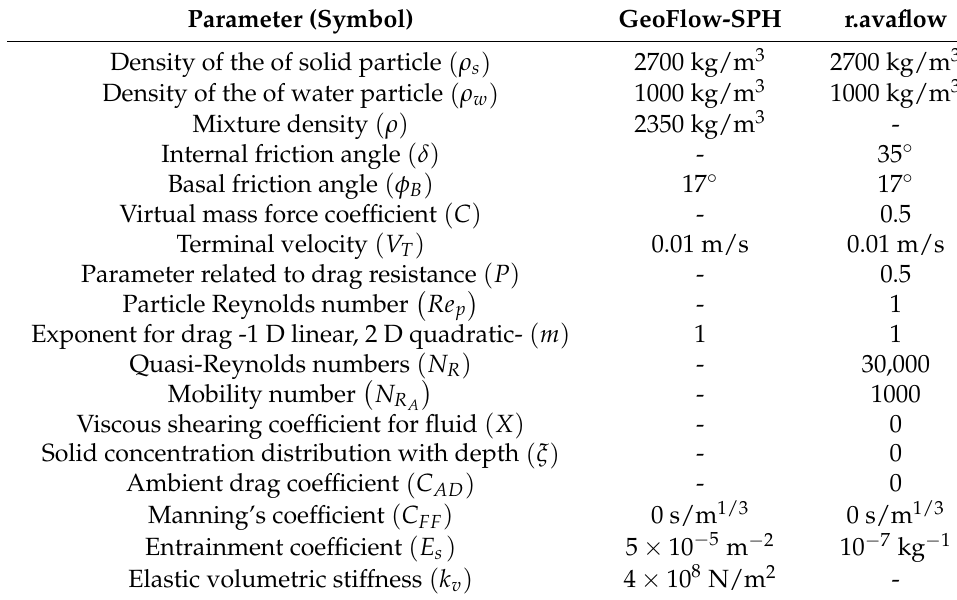
Table 1. Material parameters used in the analysis of the avalanche. Parameter